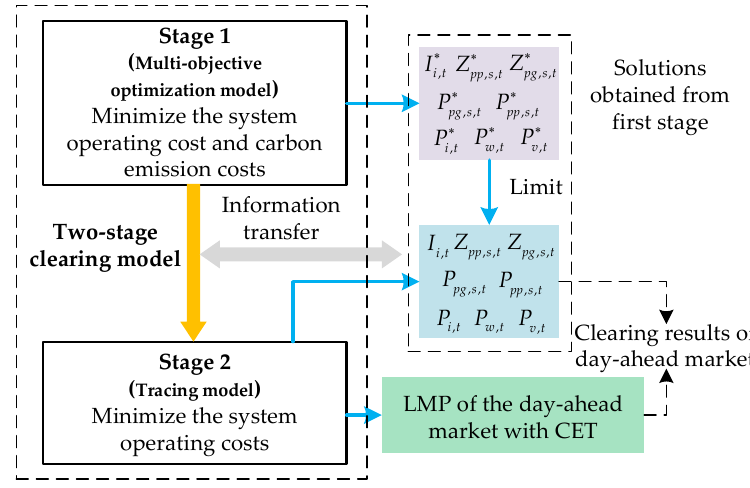
Figure 3. Relationship between the two stages of the model.